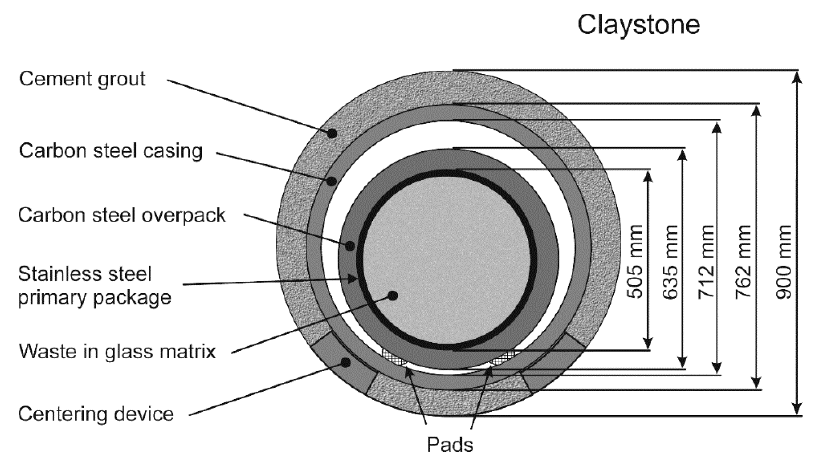
Figure 1. The envisioned multi-barrier concept for the French disposal of high-level radioactive waste: cross-sectional view.